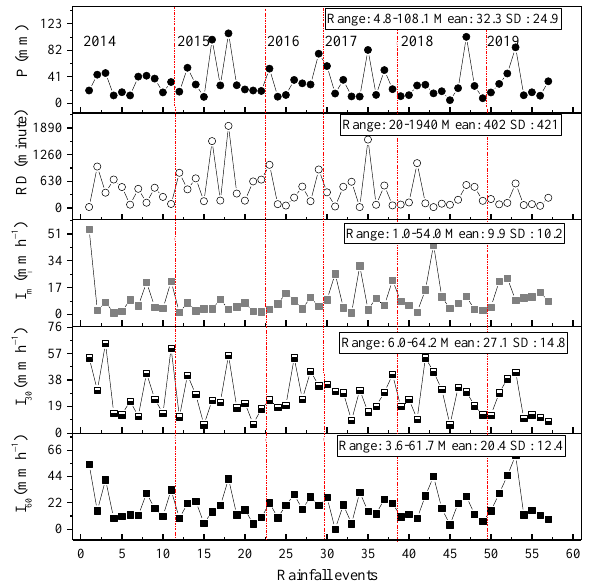
Figure 3. Rainfall characteristics of the recorded 57 erosive rainfall events in 2014–2019. Note: P represents rainfall amount; RD represents rainfall duration; I m , I 30 , and I 60 represent mean, maximum 30, and maximum 60 rainfall intensity, respectively.